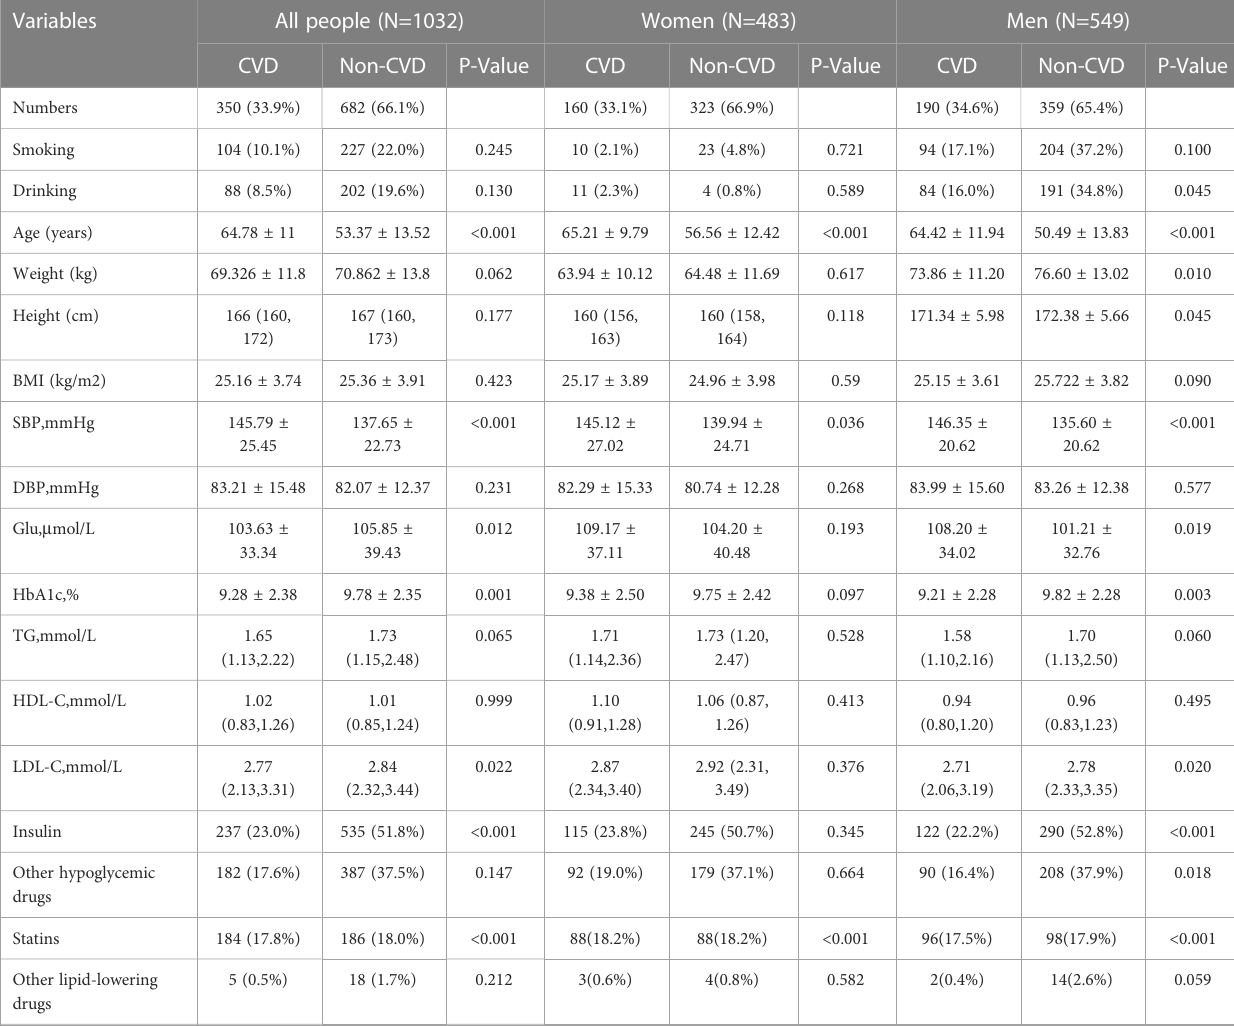
TABLE 1 Clinical and biochemical characteristics of participants according to the occurrence of